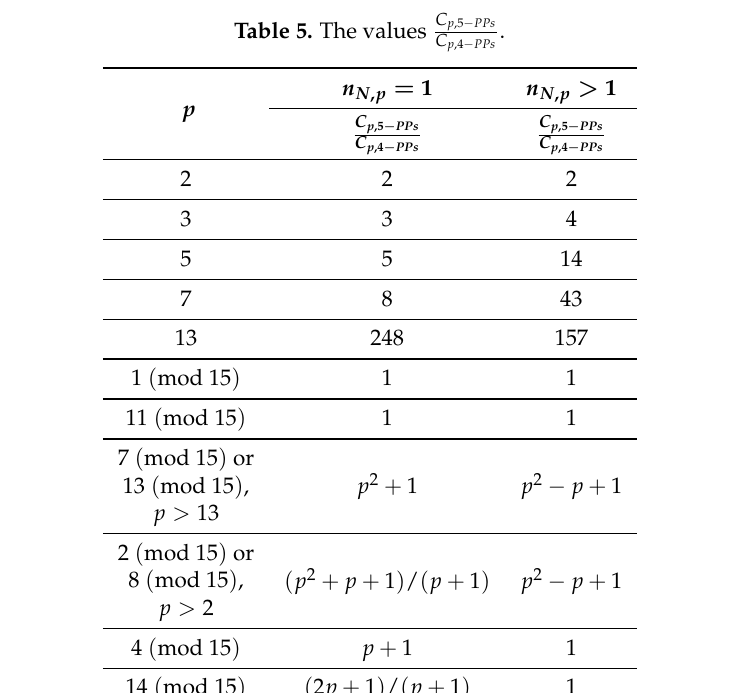
Table 5. The values C p ,5 − PPs